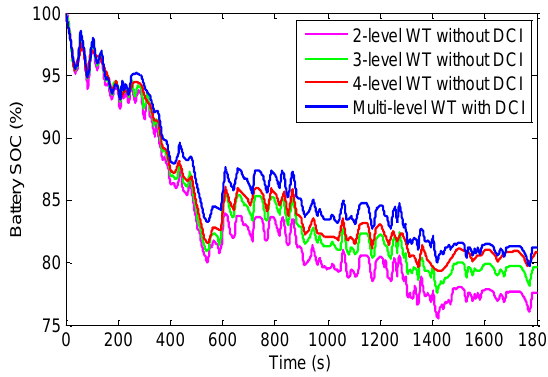
Figure 24. State of charge (SoC) comparison of battery bank. WT, wavelet transform; DCI, driving cycle identification.